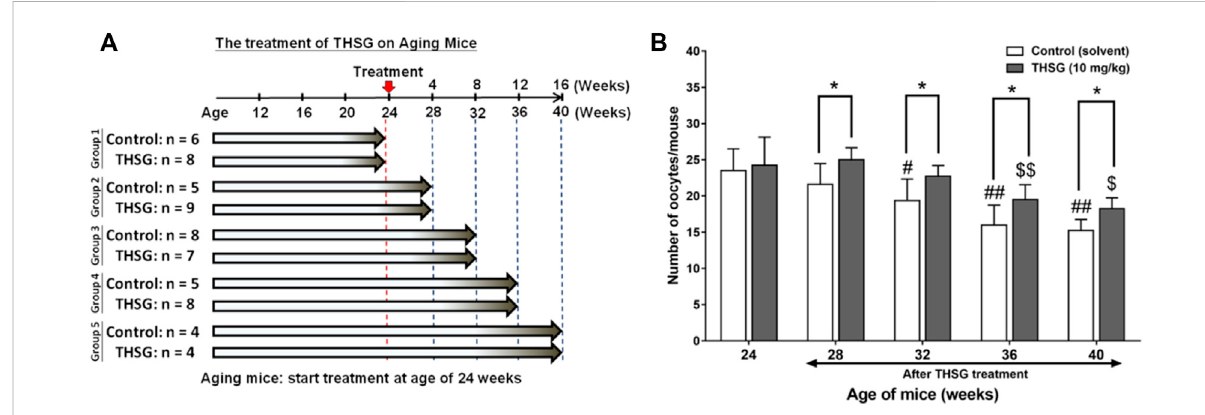
FIGURE 5 THSG treatment enhances oocyte quantity in aged mice groups. (A) Female C57BL/6J mice (24 week-old) were received 10 mg/kg THSG (in 50%ethanol;experimentgroup)orsolvent(50%ethanol;controlgroup) for16 weeks via gavagefeeding. (B) Oocytesofeachmousewerecollected fromoviducts14 hafterhCGadministration.Dataareexpressedasthemean±SD;* p < 0.05,comparedwitheachage-matchedcontrolgroup;# p < 0.05, ## p < 0.01, compared with the control group of 24-week-old mice; $ p < 0.05, $$ p < 0.01, compared with the THSG-treated group of 24-week-old